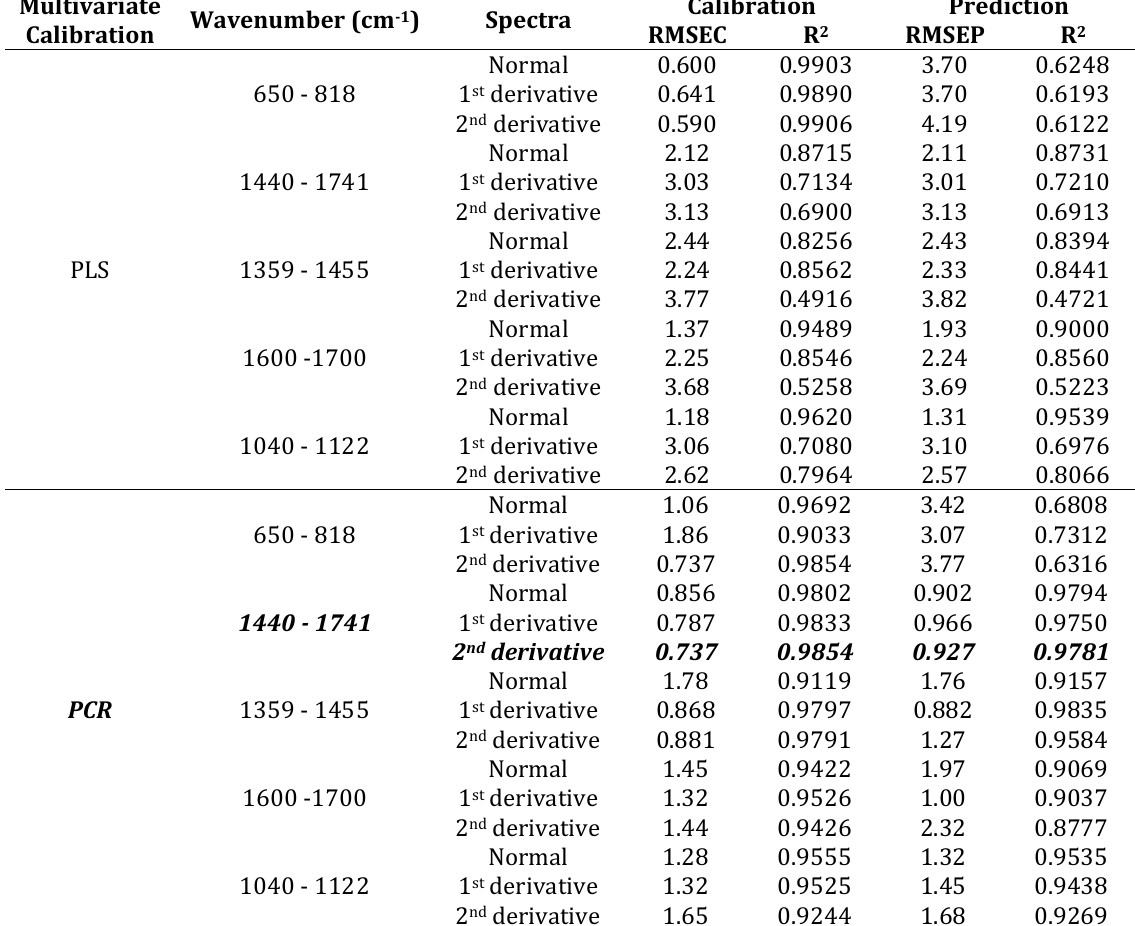
Table I. The optimization of multivariate calibrations of principle component regression (PCR) and partial least square (PLS) for prediction of radical scavenging activity of fish oil samples from different species